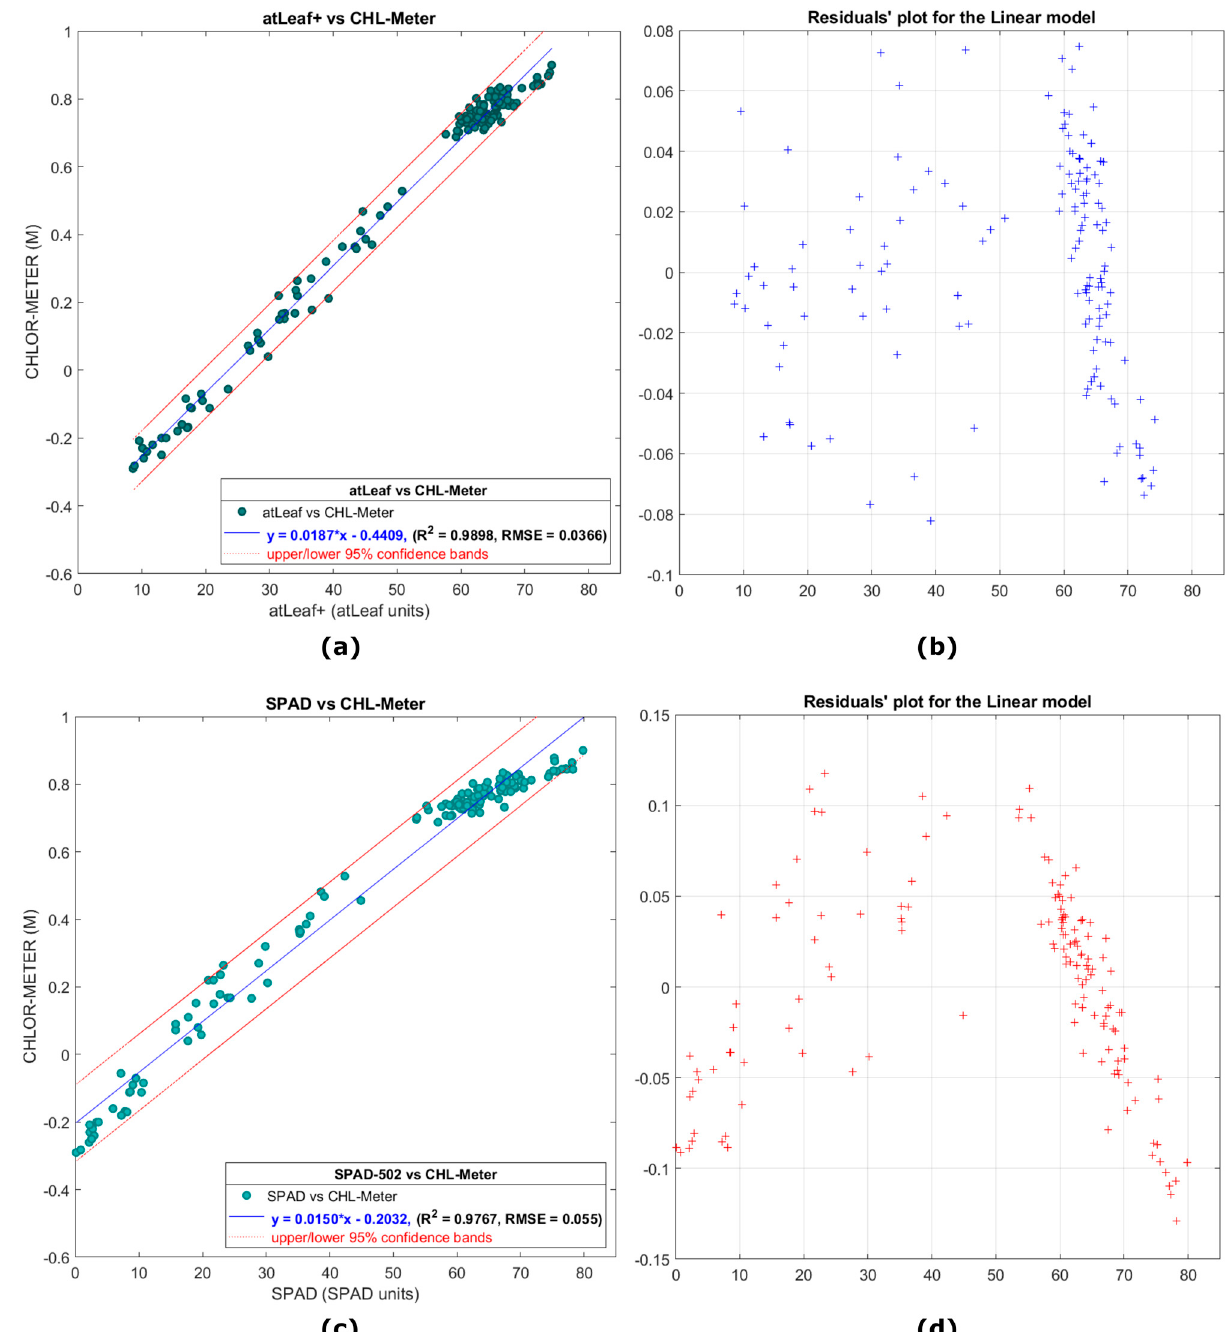
Figure 12. ( a ) A scatter plot showing the relation of data measurements with atLeaf CHL Plus and the proposed sensor in this work, on 30 lemon tree leaves, while in ( c ) the relation with the SPAD-502 is shown for the same data measurements. The red (dotted) lines correspond to 95% confidence prediction intervals. In ( b , d ), plots of the residuals (marked with +) for the simple linear regression model fit in each case applied on data plotted on ( a , c ) are shown, respectively.